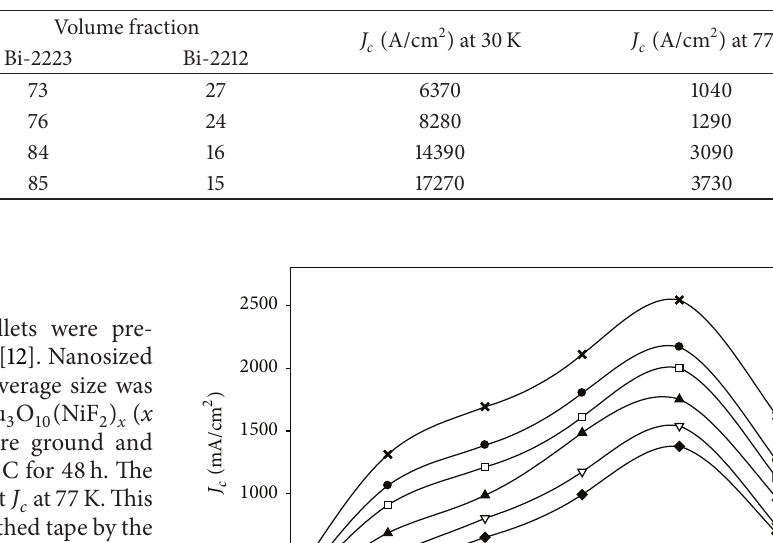
Table 1: Volume fraction and critical current density (at 30 K and 77 K) of 𝑥 = 0 and 0.04 wt.% of 10nm NiF for 50 and 100h.